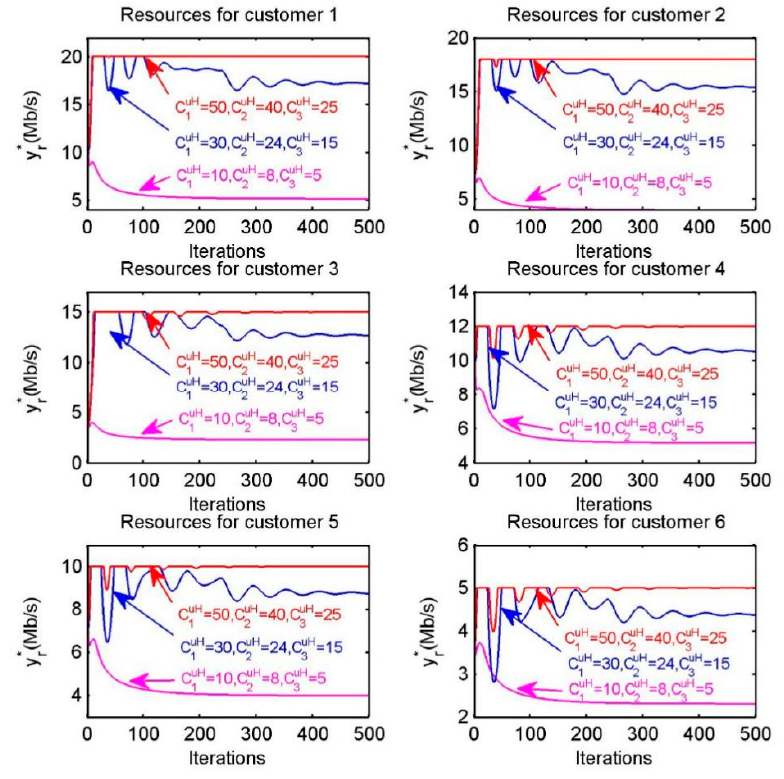
Figure 11. Resource allocation of each customer 𝑟 when increasing the upload capacity of providers.